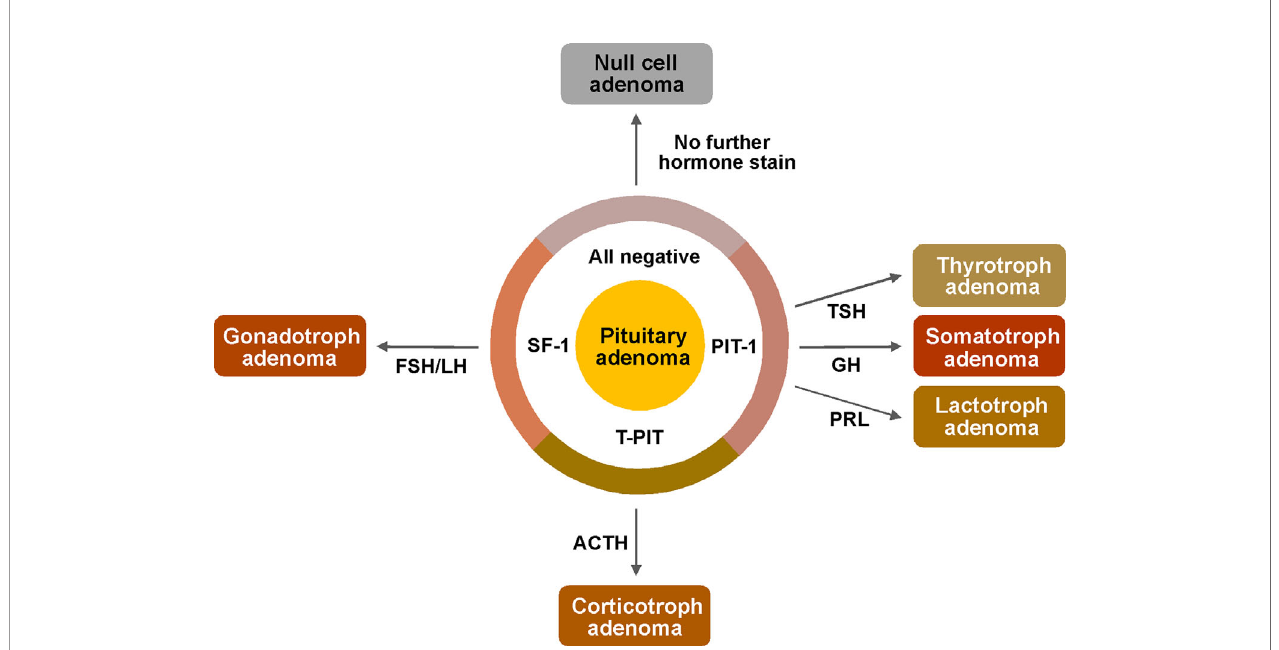
FIGURE 1 | Pathological examination protocol for pituitary adenomas based on the new WHO classi fi cation. First, immunostains of transcriptions factors (PIT-1, T-PIT and SF-1) were performed for determination of cell lineage. And then, following stains were performed only for possibly associated hormones based on the result of TF stains; GH, PRL and TSH for PIT-1 positive adenomas, only ACTH for T-PIT positive adenomas and LH, FSH for SF-1 positive adenomas. ACTH, adrenocorticotropic hormone; FSH, follicle stimulating hormone; GH, growth hormone; LH, luteinizing hormone; PIT-1, pituitary speci fi c transcription factor 1; PRL, prolactin; SF-1, steroidogenic factor 1; T-PIT, pituitary cell restricted factor; TSH, thyroid stimulating